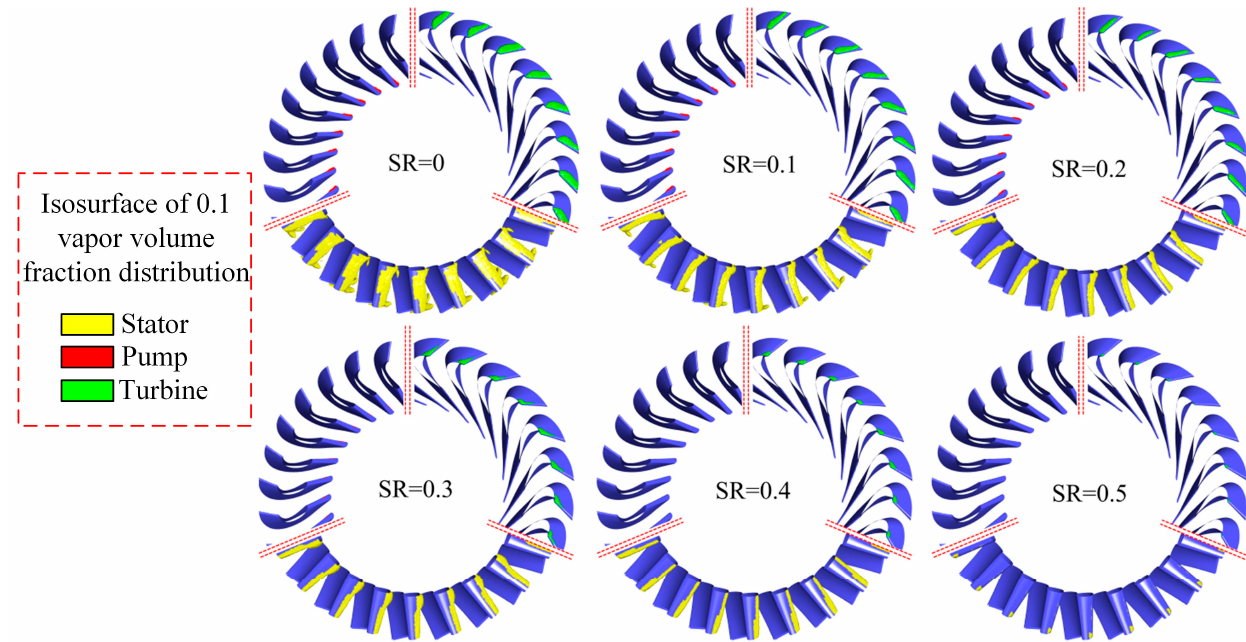
Figure 13. Vapor volume fraction distribution under various SR with SBES model.